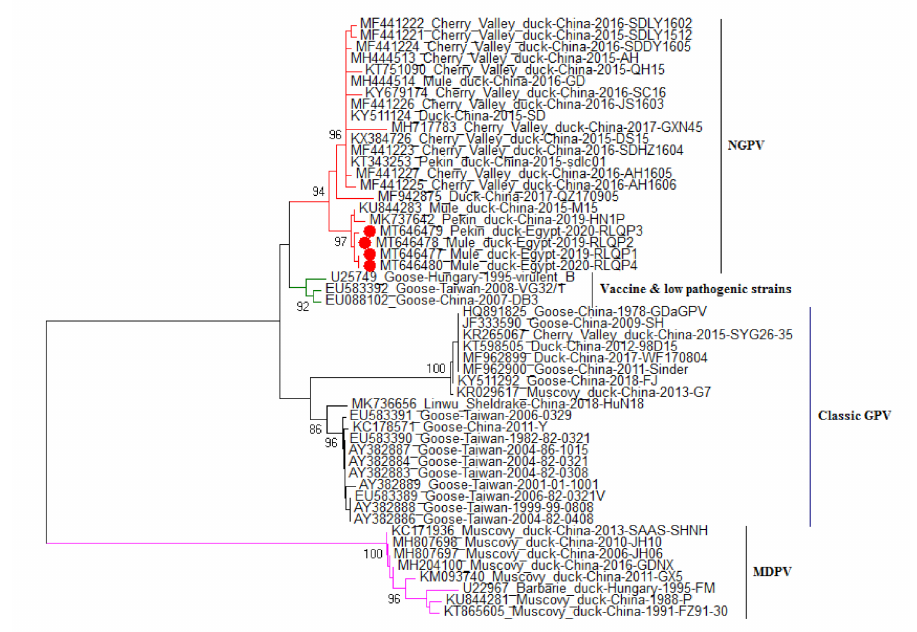
Figure 5. VP1 gene Phylogenetic tree, with four Egyptian NGPVs (Novel Goose Parvovirus) strains (indicated by red dots) and other waterfowl parvovirus isolates with sequences available in the GenBank database. The phylogenetic tree was constructed using the neighbor-joining algorithm with 1000 bootstrap replicates. Bootstrap values are shown on the tree.